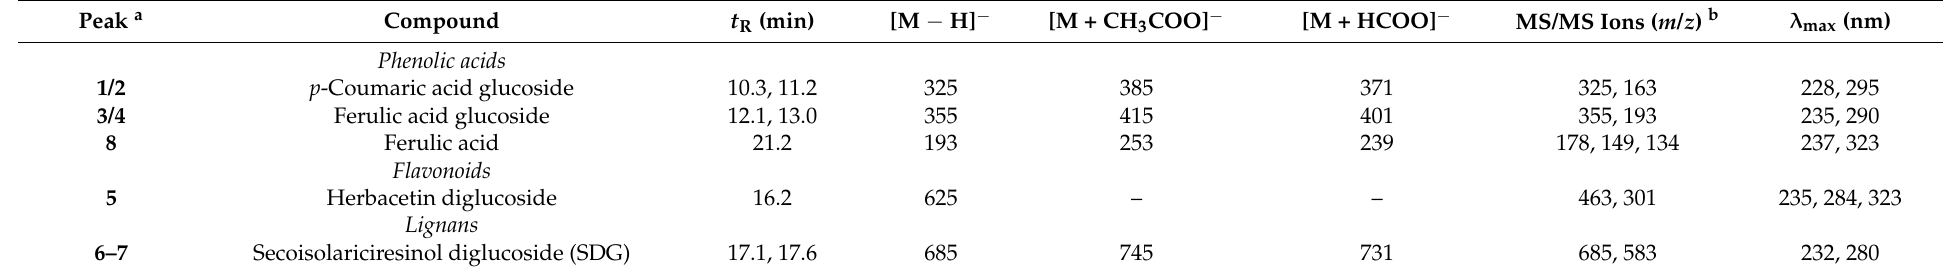
Table 3. Spectral (UV and ESI–MS/MS) and chromatographic data ( t R , retention time) of compounds 1 – 8 , detected in all defatted seed meal extracts of flaxseed after the alkaline hydrolysis of secoisolariciresinol diglucoside (SDG)